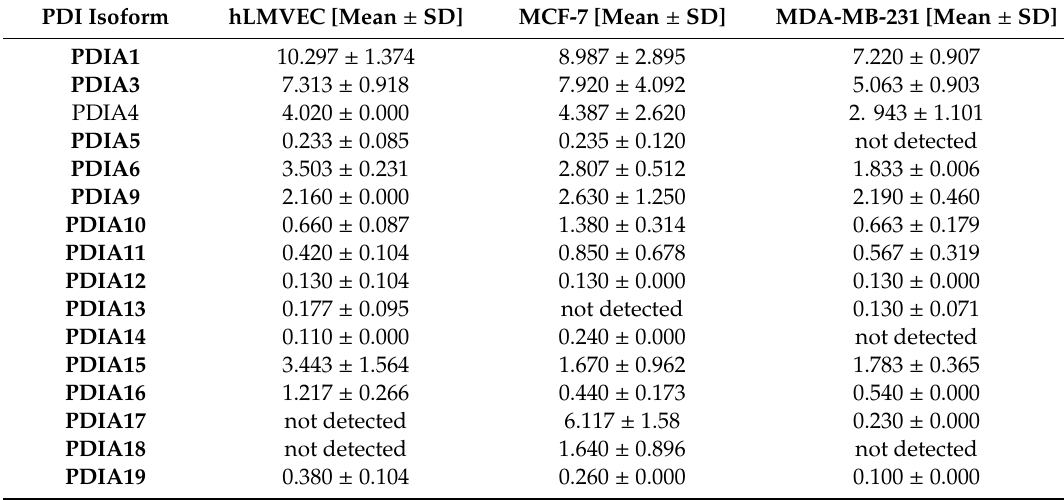
Table 1. Relative content of protein disulphide isomerases (PDIs) in hLMVEC, MCF-7 and MDA-MB-231 cell